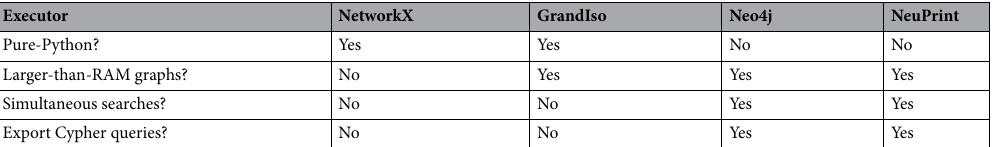
Table 2. A comparison of DotMotif executors. All executors are capable of running any of the queries in this paper. Pure Python executors are desirable due to their low configuration and installation overhead,